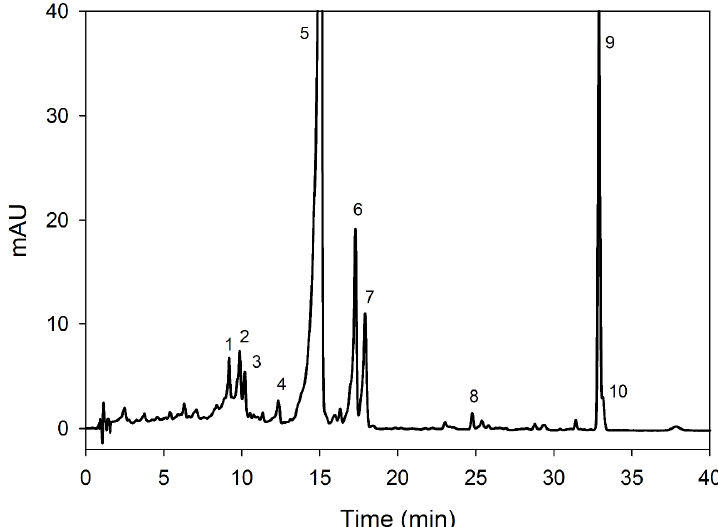
Figure 3. Representative HPLC ‐ DAD chromatograms at 450 nm of carotenoids of the apricot leaves. Numbers above the peaks represent individual compounds with details given in Table 2.